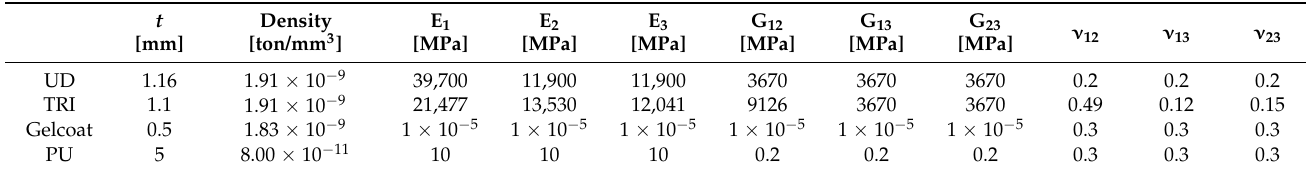
Table 1. Material properties for the materials used in the current study.